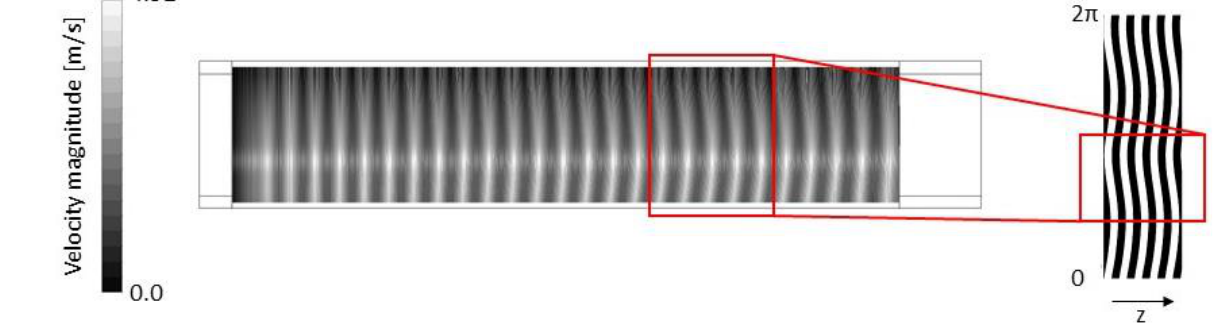
Figure 11. Depiction of Taylor vortices in simulations, performed following the workflow ( left ), and from the results of Hwang [18] ( right ). The vortices in performed simulations are depicted with contours of velocity magnitude at mid-radial height.